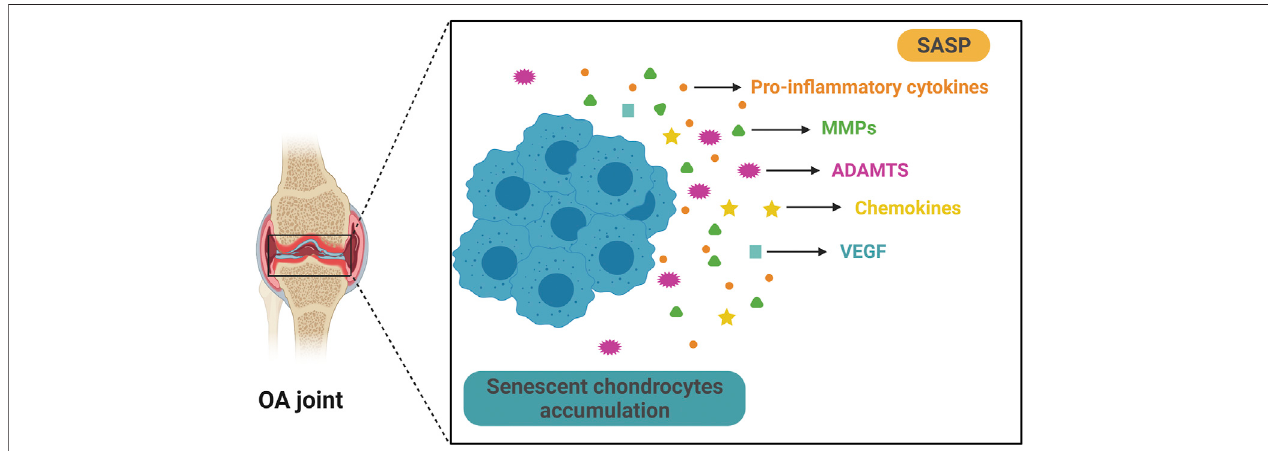
FIGURE 2 | Senescent chondrocytes accumulate and secrete SASP in OA. Aging is signi fi cantly associated with OA and senescent articular chondrocytes playakeyroleinOAprogression.Senescentchondrocytes existandaccumulateinOAjointandtheysecretemultipleSASPs,suchaspro-in fl ammatorycytokine,matrix metalloproteinases (MMPs), a disintegrin and metalloproteinase with thrombospondin motifs (ADAMTS), chemokine and vascular endothelial growth factor (VEGF). These SASPs can cause articular cartilage damage and exacerbate pathological changes in OA.